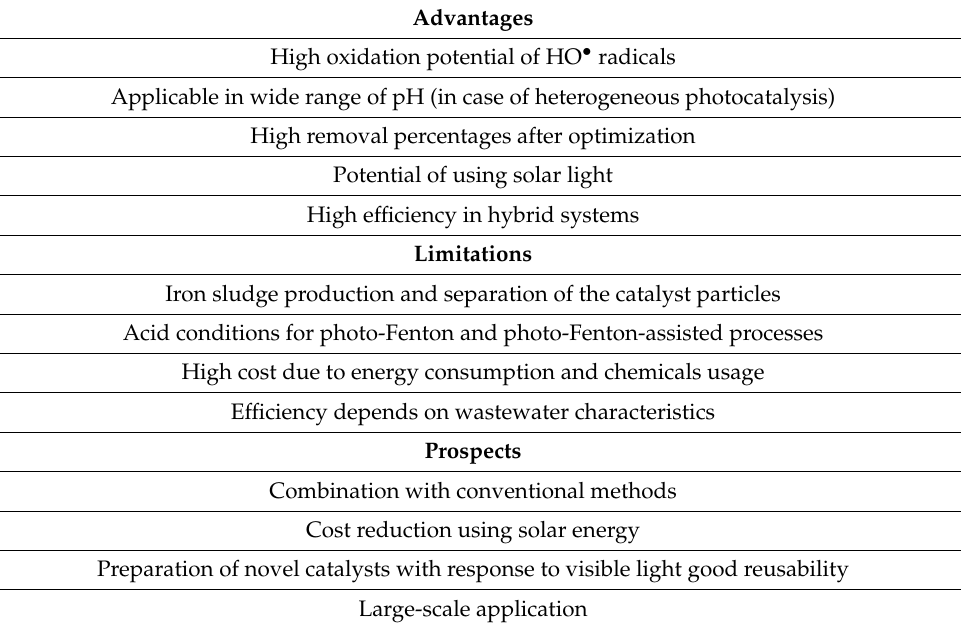
Table 6. Advantages, limitations, and prospects of photocatalytic processes for the treatment of pharmaceutical industry